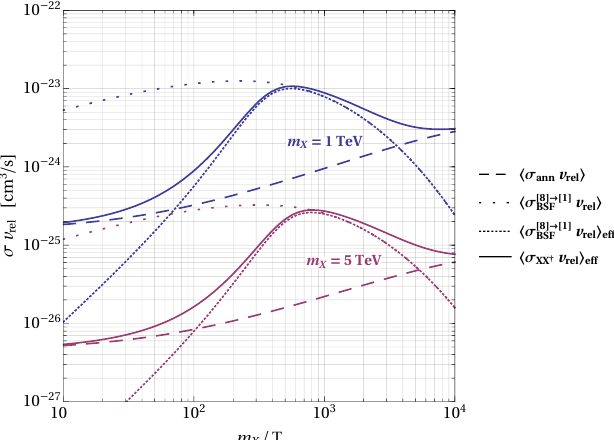
Figure 6. Dashed lines: the thermally averaged cross-section for annihilation into gluons, XX y ! gg [cf. eq. (3.10)]. Wide-spaced dotted lines: the thermally averaged cross-section for the radiative capture into the colour-singlet bound state [cf. eq. (3.15)]. Densely spaced dotted lines: the e(cid:11)ective bound-state formation cross-section, which is weighted by the fraction of XX y pairs that decay into radiation, rather than getting ionised [cf. eq. (3.23)]. Solid lines: the total e(cid:11)ective cross-section of processes that deplete XX y pairs [cf. eq. (3.24)]. This determines the DM e(cid:11)ective annihilation cross-section via eq.